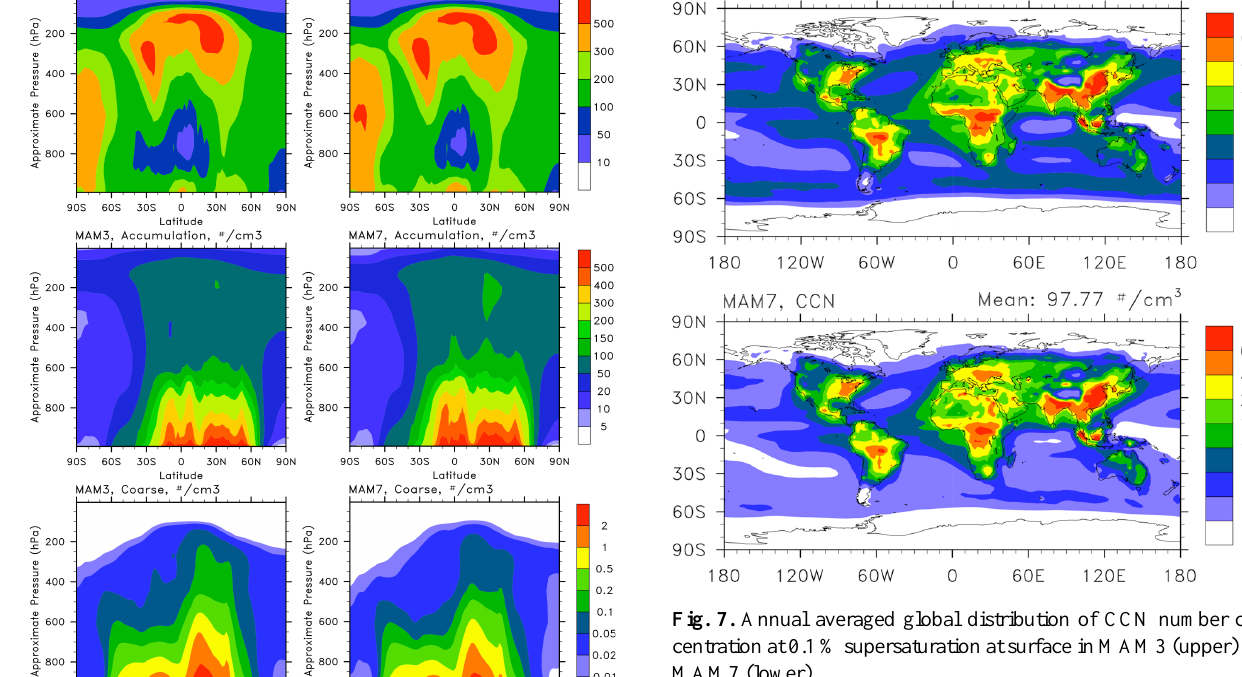
from literature by Liu et al. (2005). For aerosol species, the averages and standard deviations of available models that participated in the AeroCom project (Textor et al., 2006) are listed for comparison as “AeroCom”.